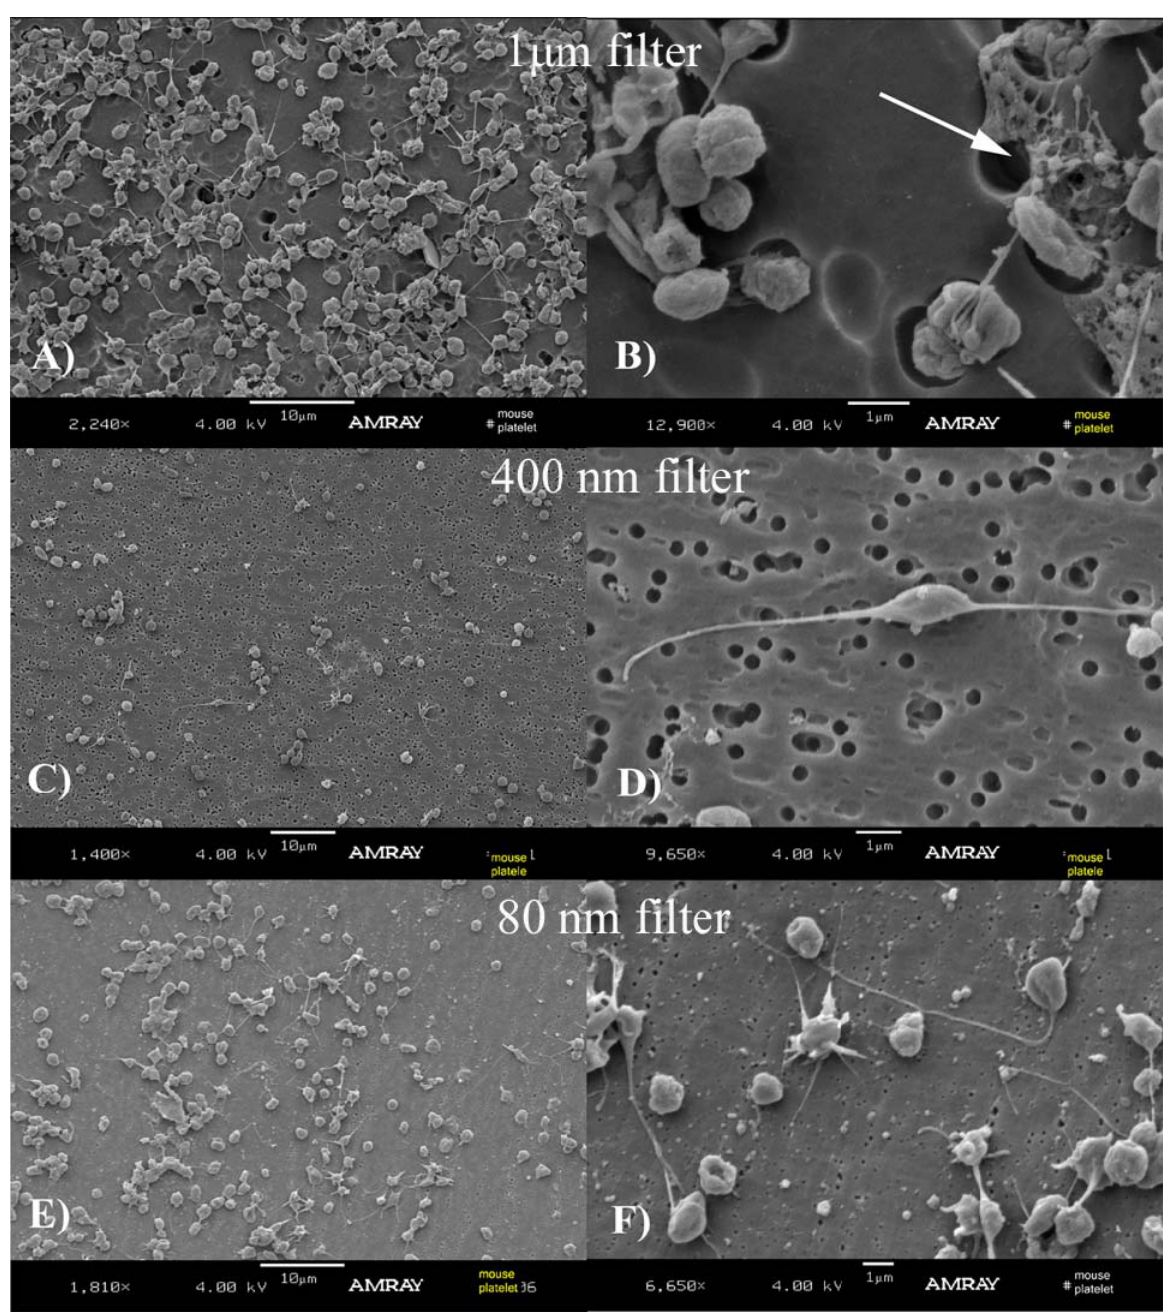
Figure 3. Platelets and MPs obtained using platelet separation (PLAT) protocol (described in detail in Figure 1C). The suspensions of platelet rich plasma were separately filtered through 1 µm ( A ), 400 nm ( C ) and 80 nm filters ( E ) (magnification of the same shown respectively in B , D and F ). As indicated in Figure 2, this demonstrates that most MPs have been eluted using the 1 µm and 400 nm filters, but have been retained by the 80 nm. The cells and MPs were extracted from true controls where no ligation procedure was